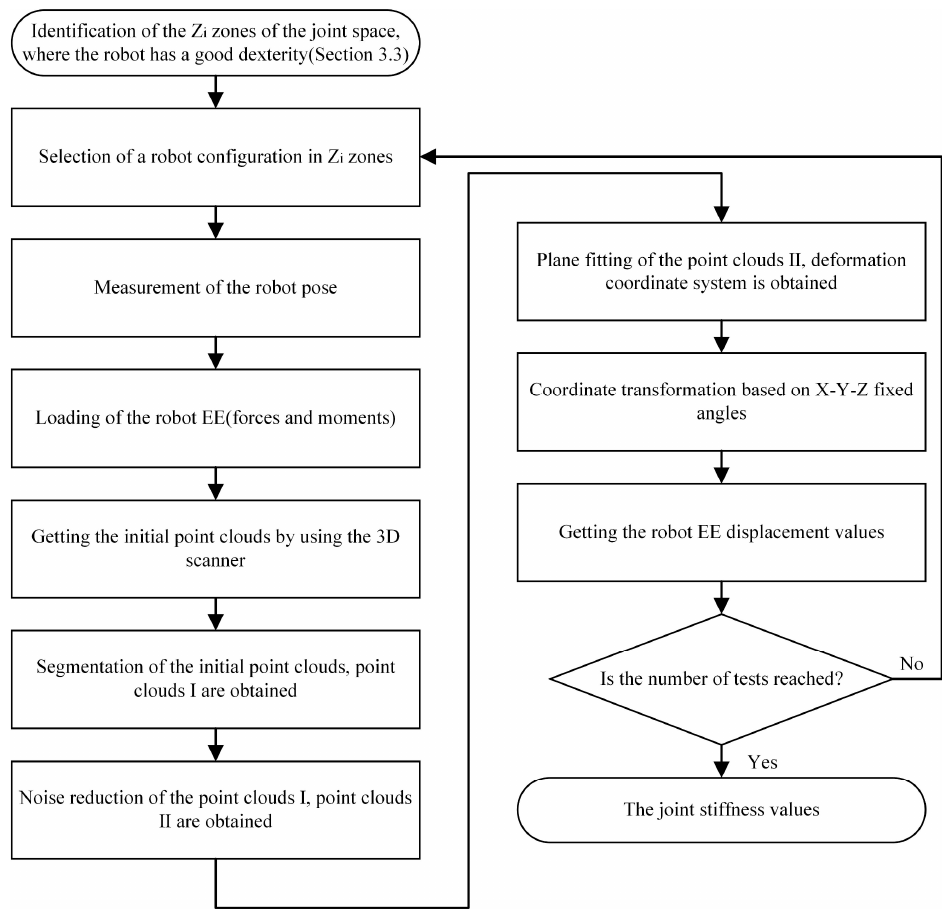
Figure 6. Procedure for the joint sti ff ness identi fi cation.